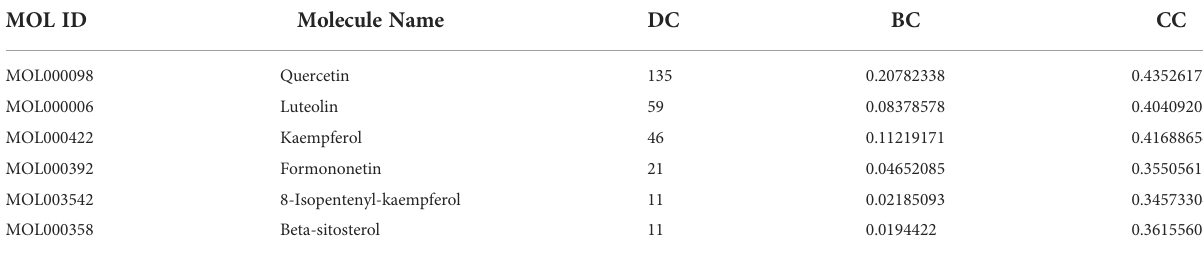
TABLE 1 Topological parameters of main active ingredients of WJR MOL